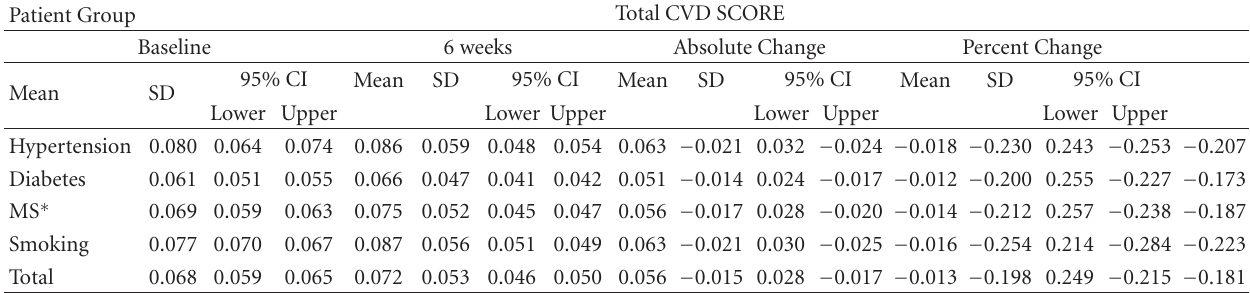
Table 3: Total CVD SCORE at baseline and final (6-week)